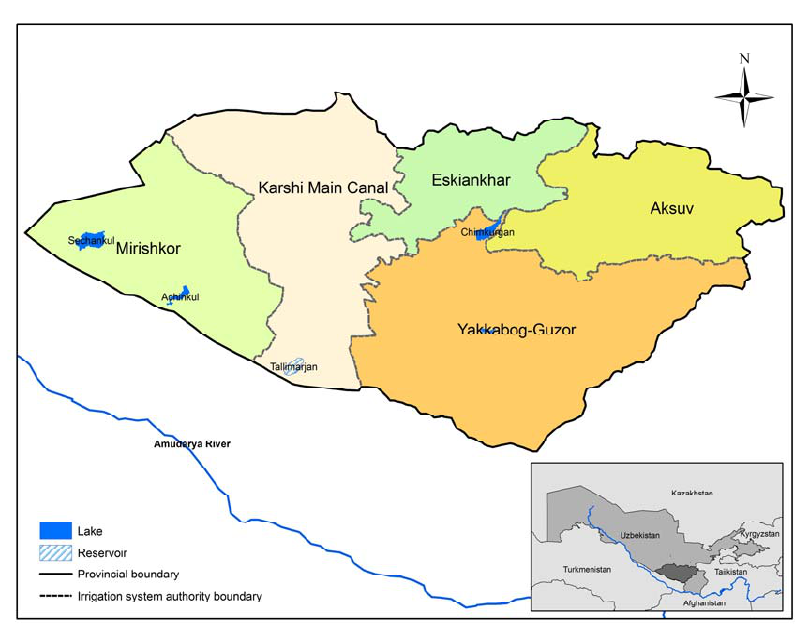
Figure 1. Location of the study area in Kashkadarya Province, including five ISAs.